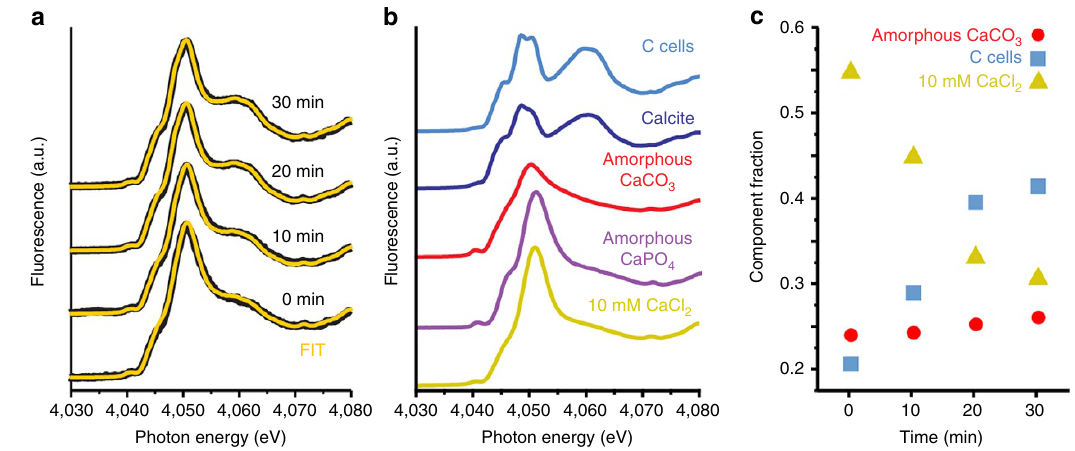
Figure 1 | Speciation of cellular calcium during the early stages of coccolith formation in E. huxleyi . ( a ) Time-resolved evolution of the XANES spectra (black) of cells induced to form calcite and of the calculated fits (orange) using linear combinations of three reference standards (coccolith calcite, free calcium ions and amorphous CaCO 3 ). ( b ) Ca K-edge XANES spectra of calcium reference standards and of E. huxleyi cells enclosed by a sphere of coccoliths (C cells). Free calcium ions were represented by 10mM CaCl 2 solution. The spectrum of amorphous calcium phosphate is courtesy of Diane Eichert, Elettra synchrotron, Trieste, Italy 47 . The spectrum of C cells showed the characteristic feature of calcite and was used instead of synthetic calcite for fitting the spectra of induced cells. ( c ) Relative contribution of the calcium references to the three component fits shown in a .